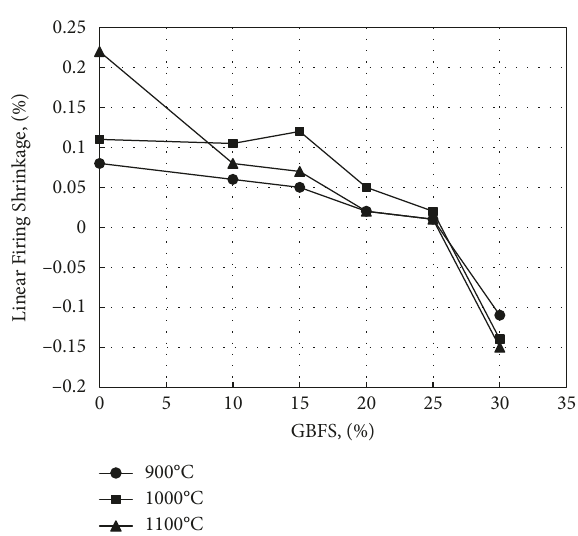
Figure 5: Effect of GBFS addition on linear firing